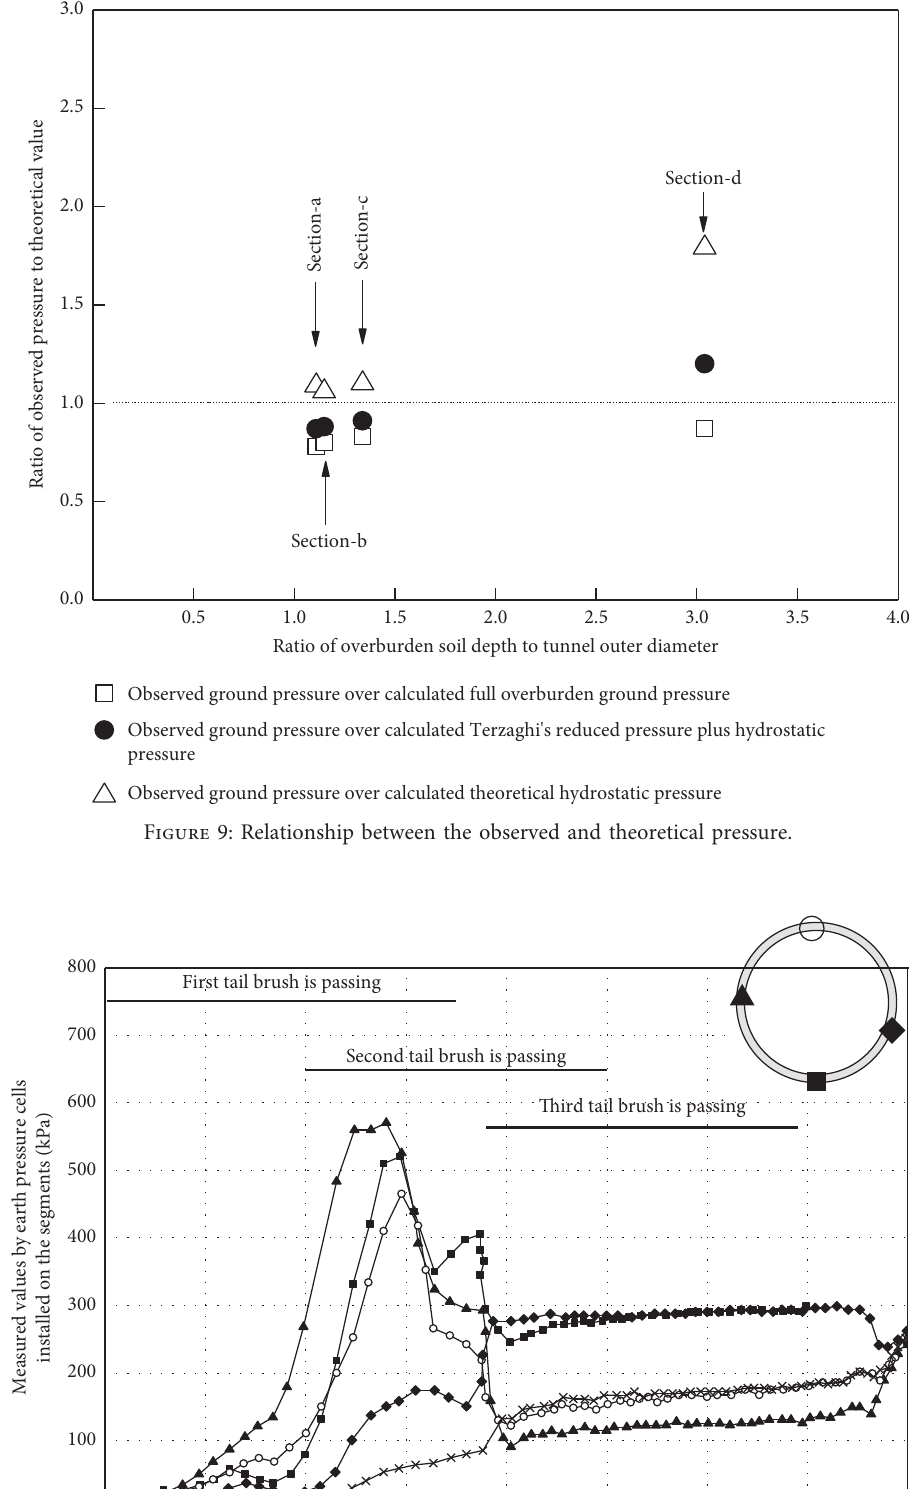
Figure 10: Influence of the tail brushes on the segments (reproduced from Koyama [3]).